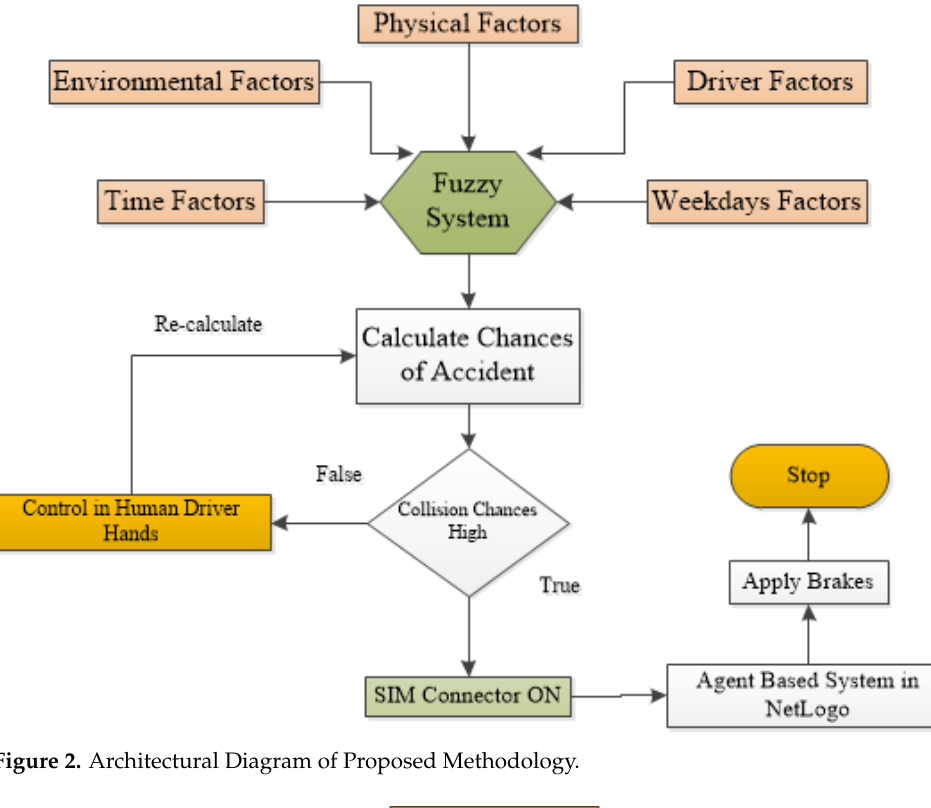
Figure 2. Architectural Diagram of Proposed Methodology.